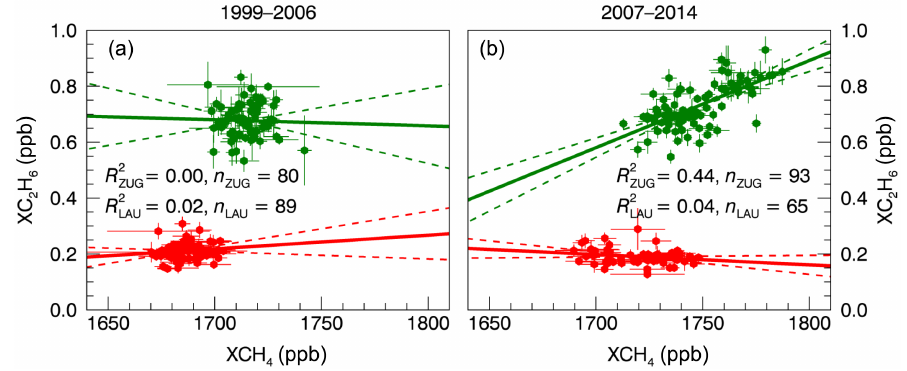
Figure 2. Scatterplots of monthly mean column-averaged ethane and methane derived from deseasonalized time series at Zugspitze (green) and Lauder (red) for the time periods of (a) 1999–2006 and (b) 2007–2014. Solid (dashed) lines show linear regression results (uncertainty on 2 σ level). Table 2. Ethane–methane correlation analysis and linear regression